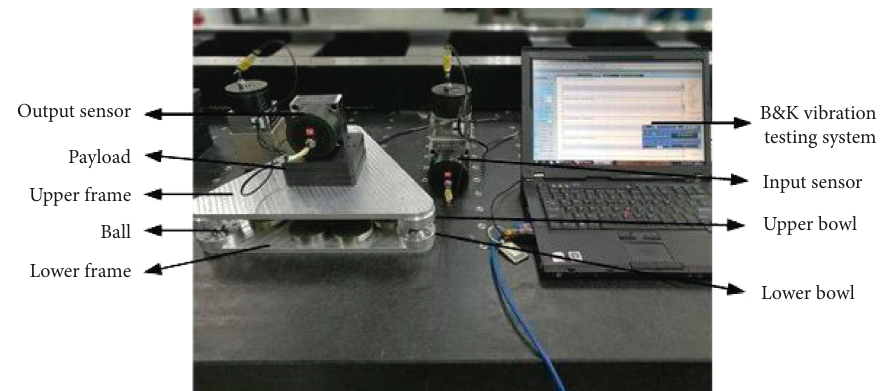
Figure 5: Photograph of the experimental device.